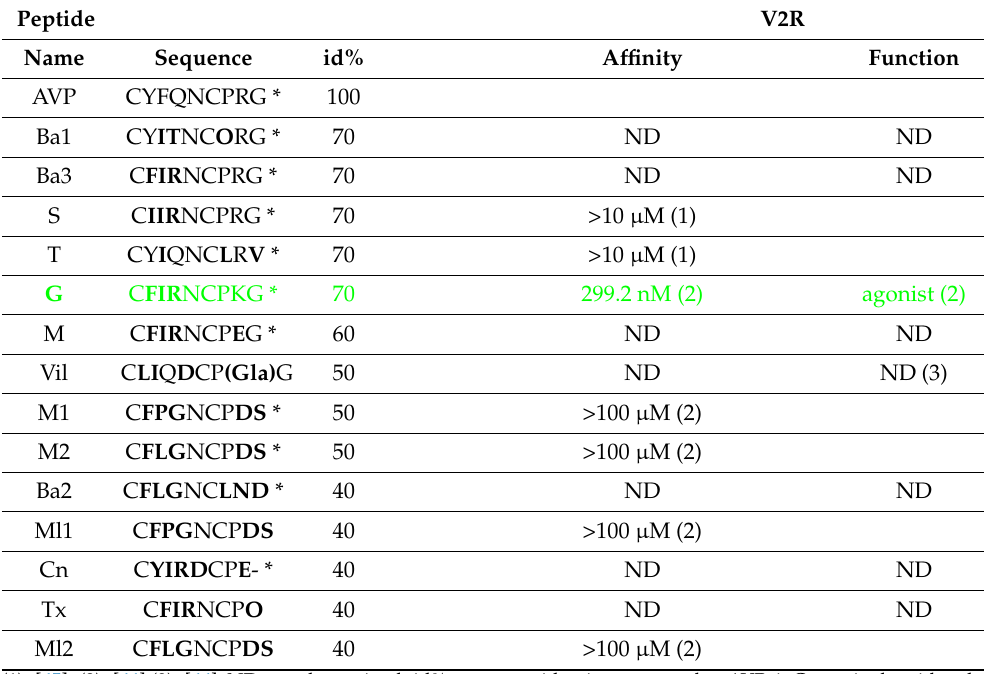
Table 1. Conopressin sequences and functions on